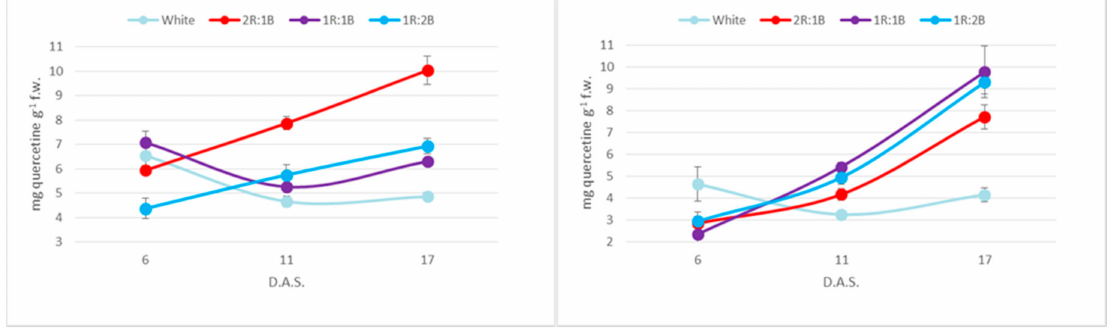
Figure 5. Flavonoid contents of: green basil cultivar ( Left ); and red basil cultivar ( Right